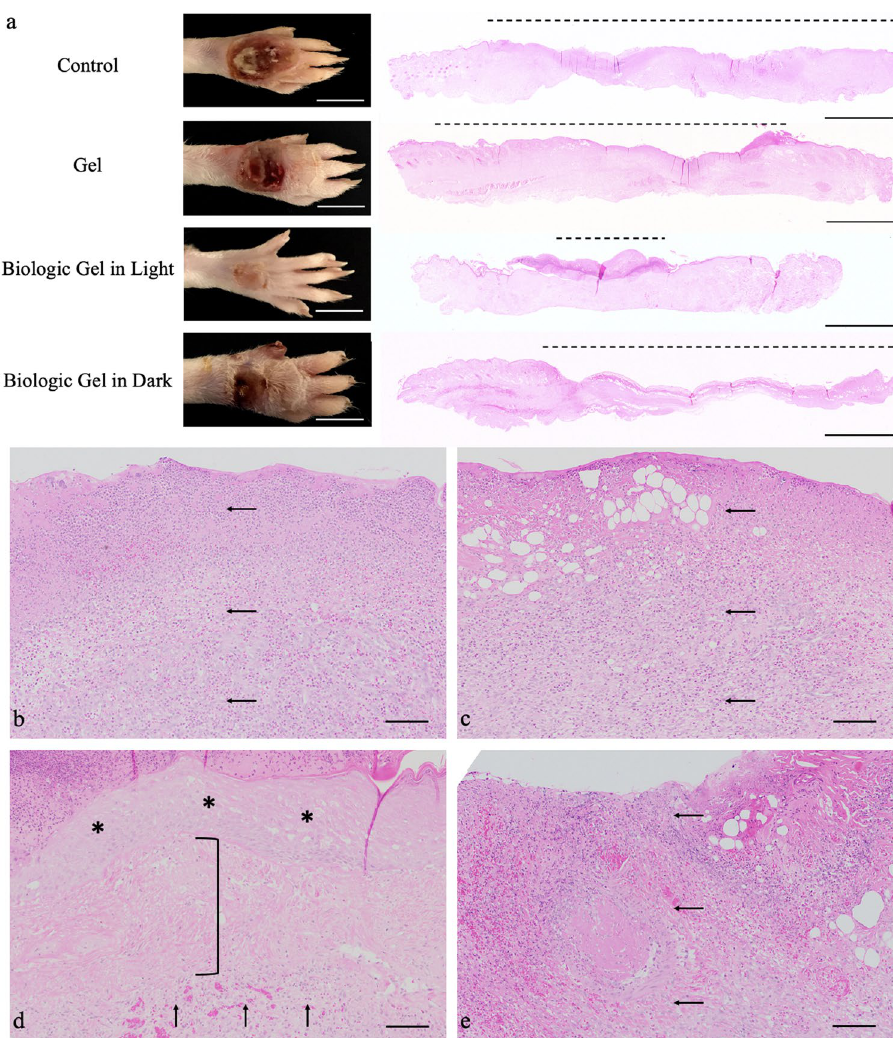
Figure 3. Gross and histopathological evaluation of tarsal wounds after 7 days of treatment in a rodent peripheral arterial disease burn wound model. ( a ) Gross tarsal lesions after 7 days of daily treatment showed smaller wound area and less ulceration in the wound that received the novel biologic gel treatment in light compared to the wounds that received other treatment. Scale bar = 1 cm. Hematoxylin and eosin stain of longitudinal sections of the tarsal lesions showed that wounds that were treated with biologic gel in light generally had less extensive ulceration (dashed lines) than wounds that received other treatment. Scale bar = 2 mm. ( b – e ) Hematoxylin and eosin stain of cross sections of the tarsal lesions under higher magnification showed that wounds that were treated with biologic gel in light ( d ) generally had milder lesions than wounds that were not treated ( b ) or treated with gel ( c ) or biologic gel treatment in dark ( e ). While biologic gel in light-treated rats exhibited granulation tissue formation admixed with inflammation ( d , vertical arrows), the distribution was less widespread, often sparing portions of the dermis (bracket). An intact epidermal layer (asterisks) was more frequently noted in biologic gel in light-treated rats. In contrast, rats that were not treated ( b ) or received gel ( c ) or biologic gel treatment in dark ( e ) exhibited widespread dermal granulation tissue admixed with necrotic tissue and inflammatory cells (horizontal arrows). Note the absence of intact epidermis and ulceration in ( b , c , e ). The control group received no treatment. Scale bar = 100